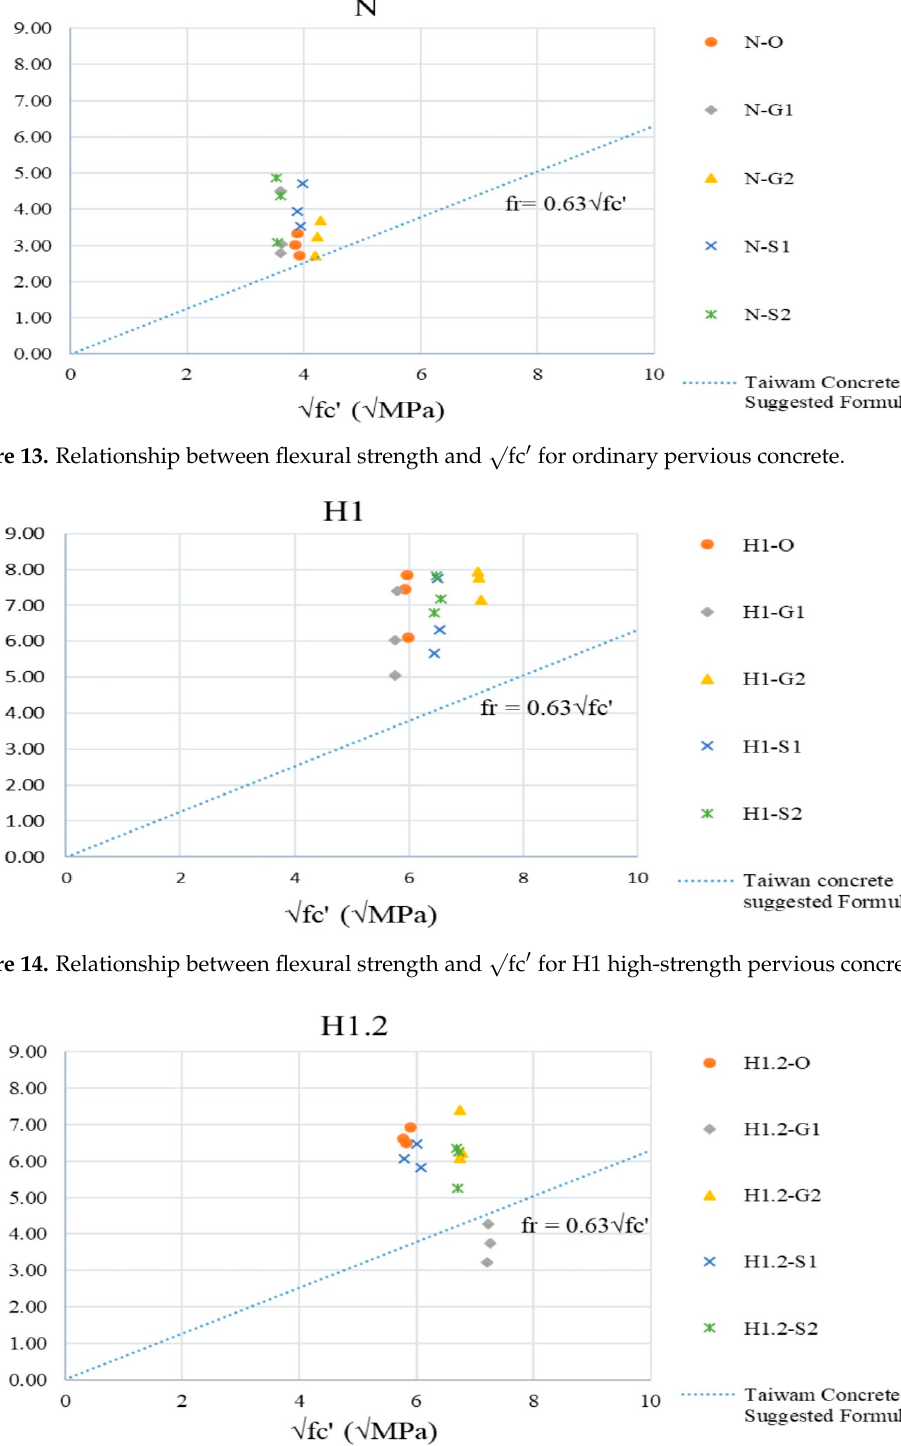
Figure 15. Relationship between flexural strength and